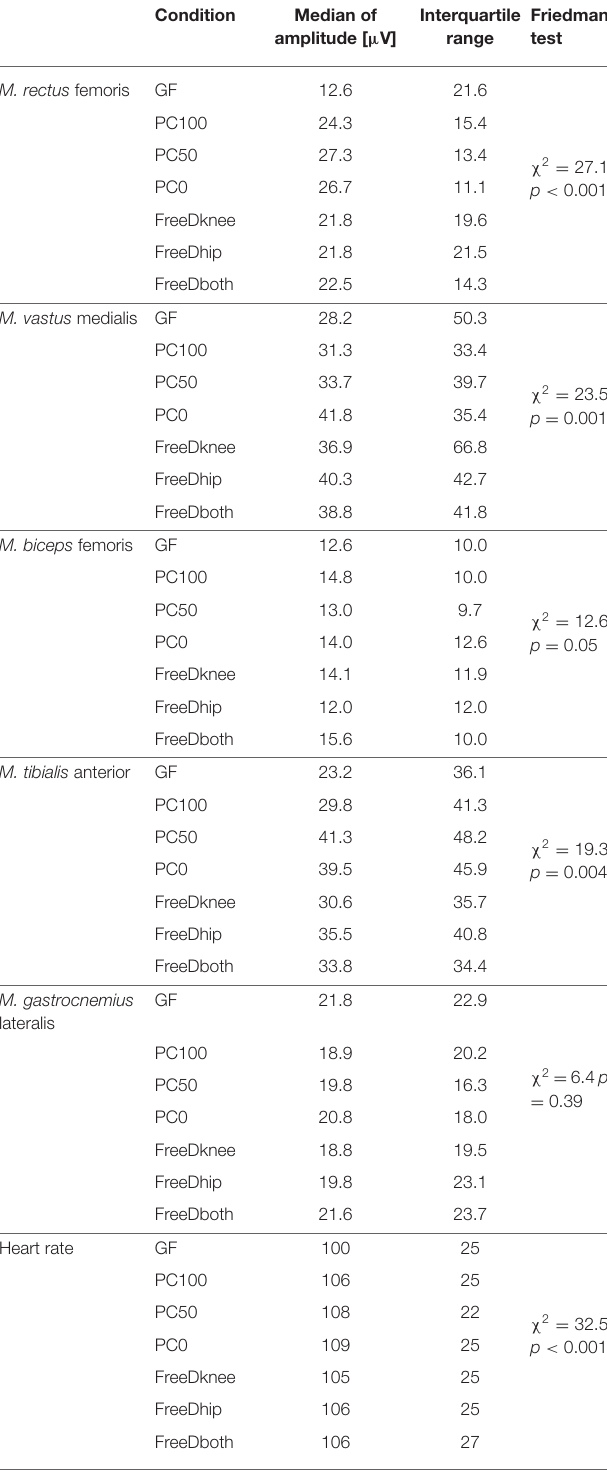
TABLE 1 | sEMG amplitudes of all conditions. TABLE 2 | Comparison of sEMG amplitudes between different path control conditions (PC100, PC50, PC0). Condition Median of Interquartile Friedman amplitude [ µ V] range test